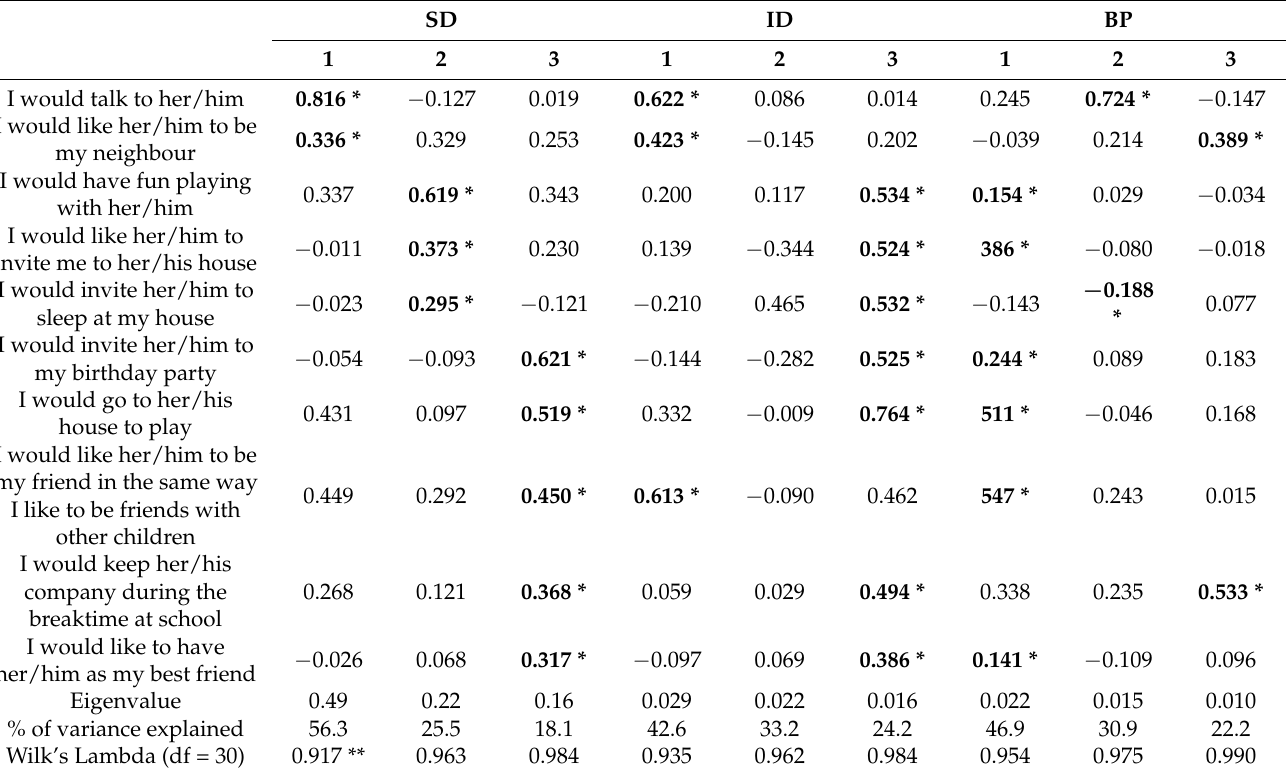
Table 4. Structure matrix emerging from the discriminant function analysis for the three disability domains. SD ID BP